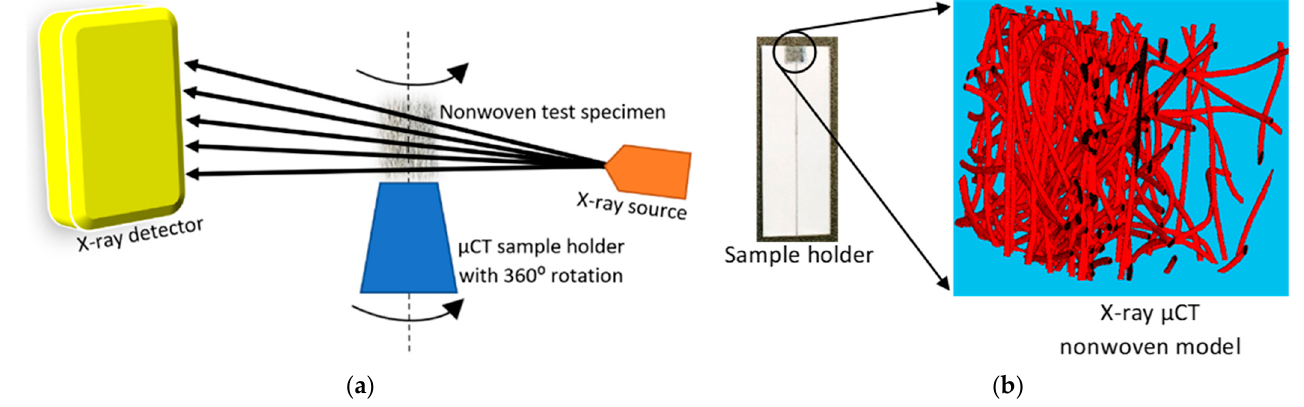
Figure 1. X-ray µ-CT system: ( a ) working procedure of X-ray µCT and ( b ) test specimen. Figure 1. X-ray µ -CT system: ( a ) working procedure of X-ray µ CT and ( b ) test